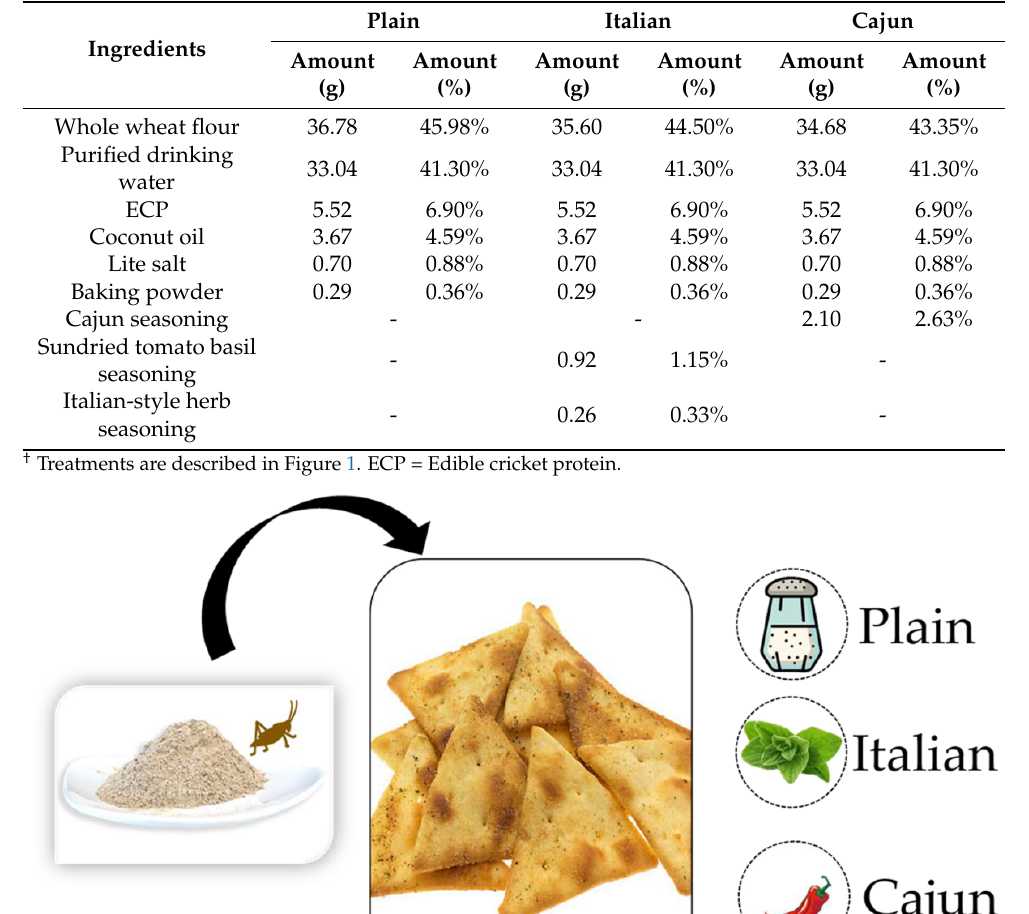
Table 1. Formulation of pita chip treatments † .